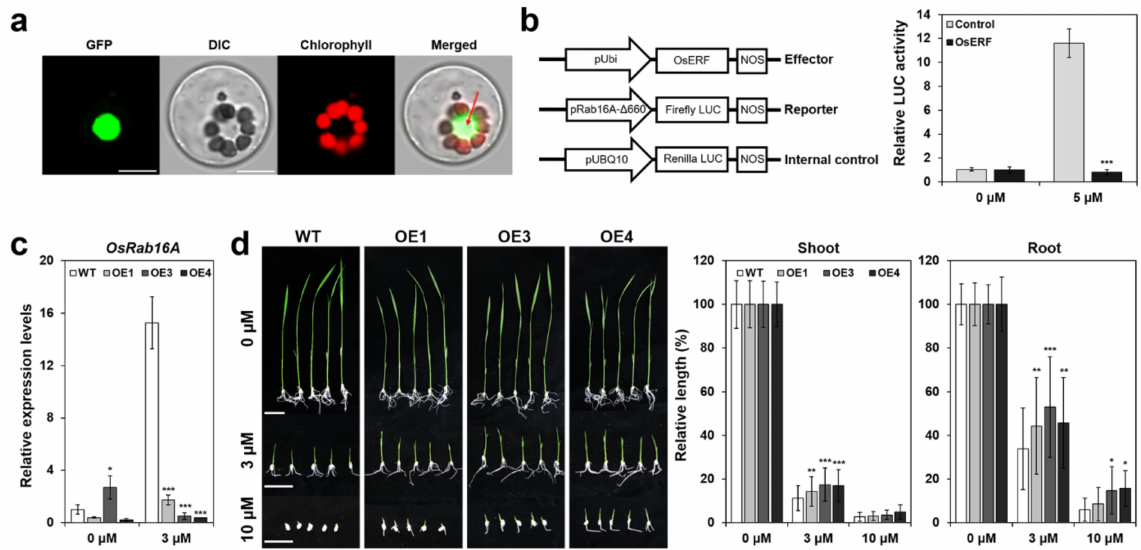
Figure 2. OsERF115/AP2EREBP110 is a nuclei targeted transcriptional regulator that suppress ABA-mediated transcrip- tional activation of Rab16A gene. ( a ) Subcellular localization of OsERF115/AP2EREBP110-GFP fusion protein in rice protoplasts. The rice protoplasts were transfected with pUbi:OsERF115/AP2EREBP110 -GFP vector, incubated for 18 h, and observed by laser-scanning confocal microscopy (Leica TCS SP8). Scale bar: 10 µ m ( b ) OsERF115/AP2EREBP110 suppressed ABA-induced transactivation of Rab16A- ∆ 660 promoter in rice protoplasts. Rice protoplasts were co-transfected with effector ( pUbi:OsERF115/AP2EREBP110-HA ), reporter ( pRab16A- ∆ 660:fLUC ), and internal control ( pUbi:rLUC ) plasmids and incubated for 18 h in the presence or absence of 5 µ M ABA. fLUC activity was normalized with rLUC activity. Schematic diagrams of the vector constructs were shown in the left panel. Control; pRab16A- ∆ 660:fLUC only. Data represent mean ( ± SD) from three independent experiments with three biological replicates. Two-way ANOVA and Fisher’s LSD test were performed compared with the control (***, p < 0.001). ( c ) ABA-induced expression of the Rab16A gene is suppressed in OsERF115/AP2EREBP110 -OE transgenic rice. Transcript level of Rab16A was analyzed by qRT-PCR. Data represent mean ( ± SD) from three independent experiments with three biological replicates ( n = 3). Two-way ANOVA and Fisher’s LSD tests were performed through comparison with WT plants as controls (*, p < 0.05; ***, p < 0.001). ( d ) OsERF115/AP2EREBP110 -OE transgenic rice was less sensitive to ABA. Transgenic and WT seeds were planted on 1/2 MS medium containing 3 or 10 µ M ABA for 7 days and shoot and root length were measured. Scale bars: 3 cm. Data represent mean ( ± SD) from two independent experiments ( n = 25 or 50). Two-way ANOVA and Fisher’s LSD test were performed by comparison with the WT plants as controls (*, p < 0.05; **, p < 0.01; ***, p <